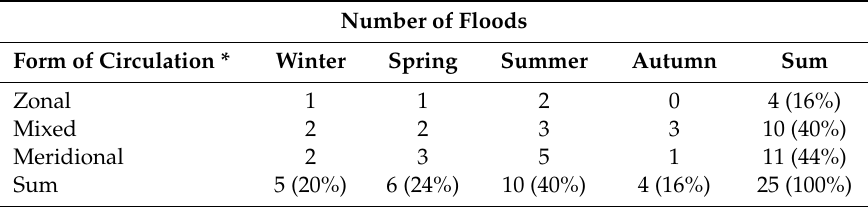
Table 4. Frequency of the most severe flood events’ form of circulation in Turkey (1960–2014). Number of Floods Form of Circulation * Winter Spring Summer Autumn Sum Zonal 1 1 2 0 4 (16%) Mixed 2 2 3 3 10 (40%) Meridional 2 3